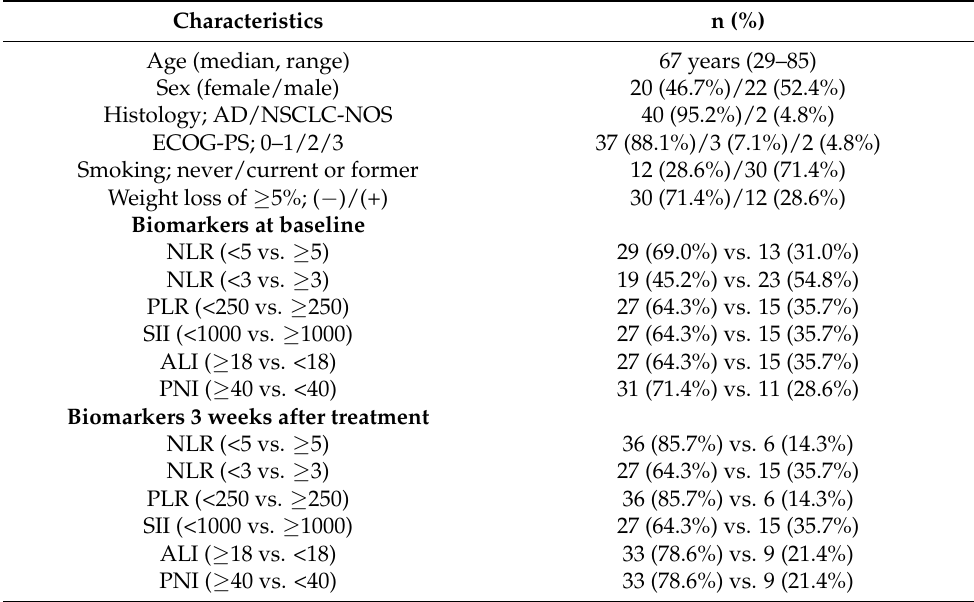
Table 1. Baseline patient characteristics.